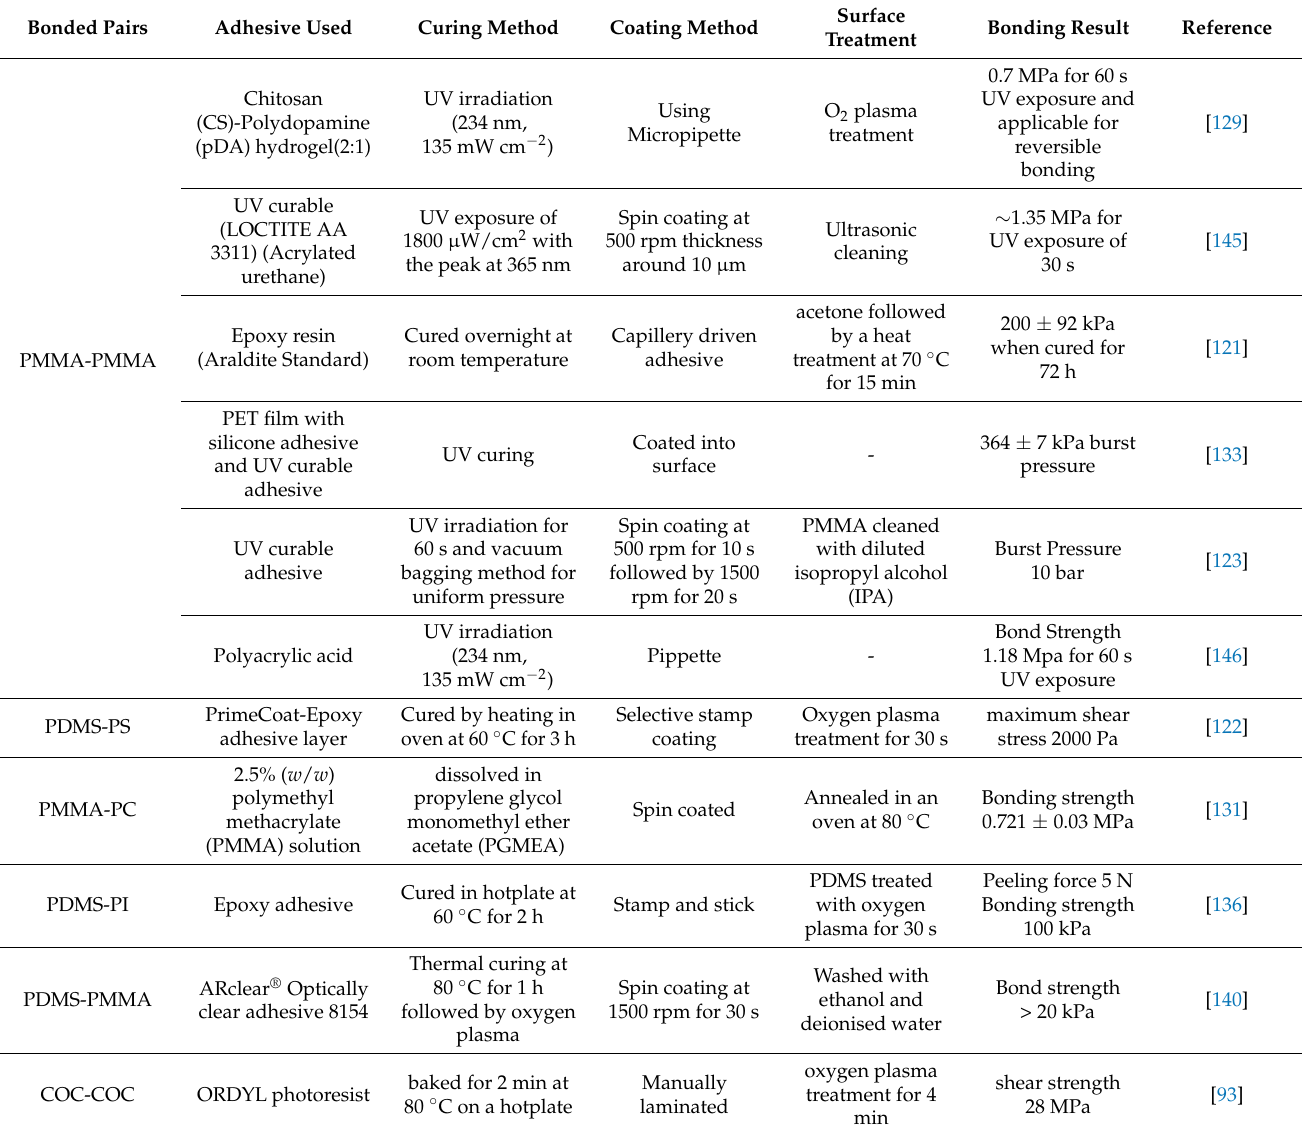
Table 5. Adhesive bonding pairs, curing method, coating method, surface treatment and bonding